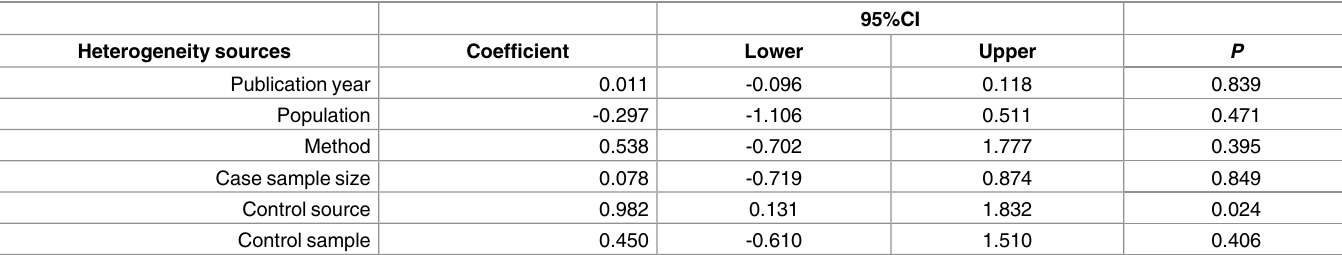
Table 2. Meta-regression analysis.